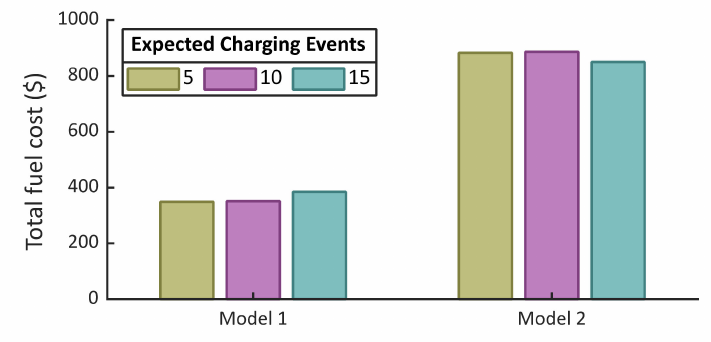
Figure 15. Total fuel cost in various